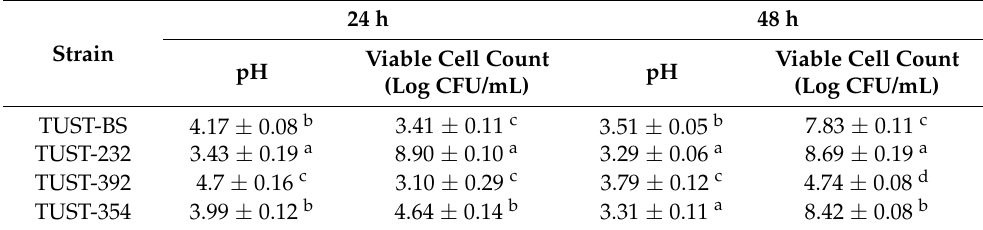
Table 1. Fermentation performance of different strains used in the R–B mixed juice.